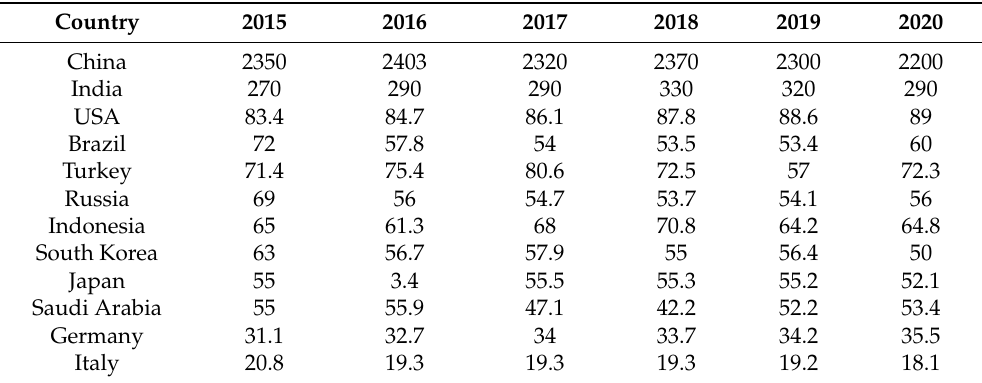
Table 2. Cement production by countries (million tons)